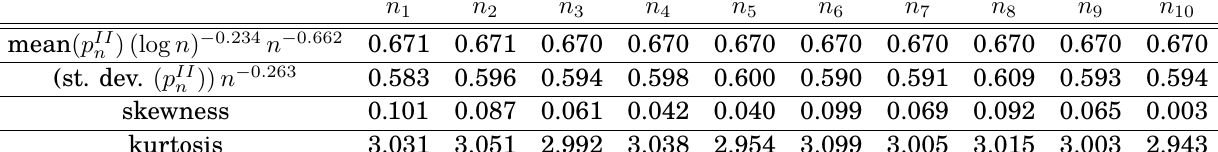
Table 4: Monte Carlo simulation results for the